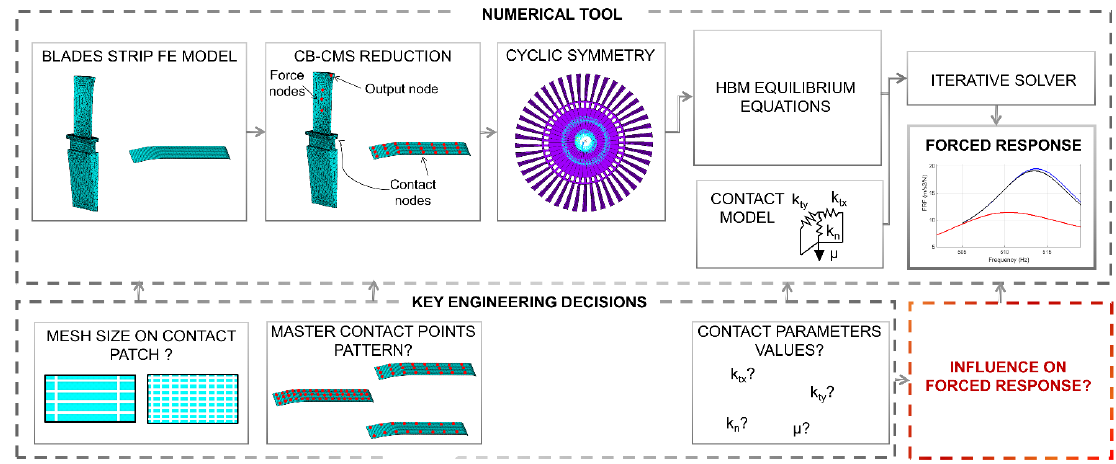
Figure 3. Scheme of the solving procedure and corresponding key engineering/modelling